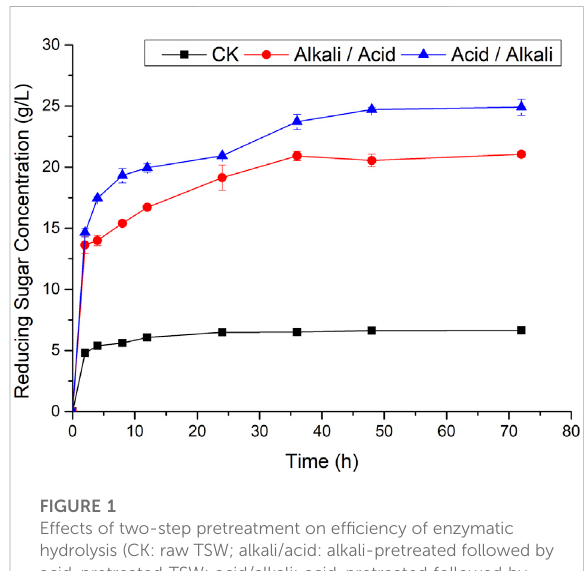
FIGURE 1 Effects of two-step pretreatment on ef fi ciency of enzymatic hydrolysis (CK: raw TSW; alkali/acid: alkali-pretreated followed by acid-pretreated TSW; acid/alkali: acid-pretreated followed by alkali-pretreated